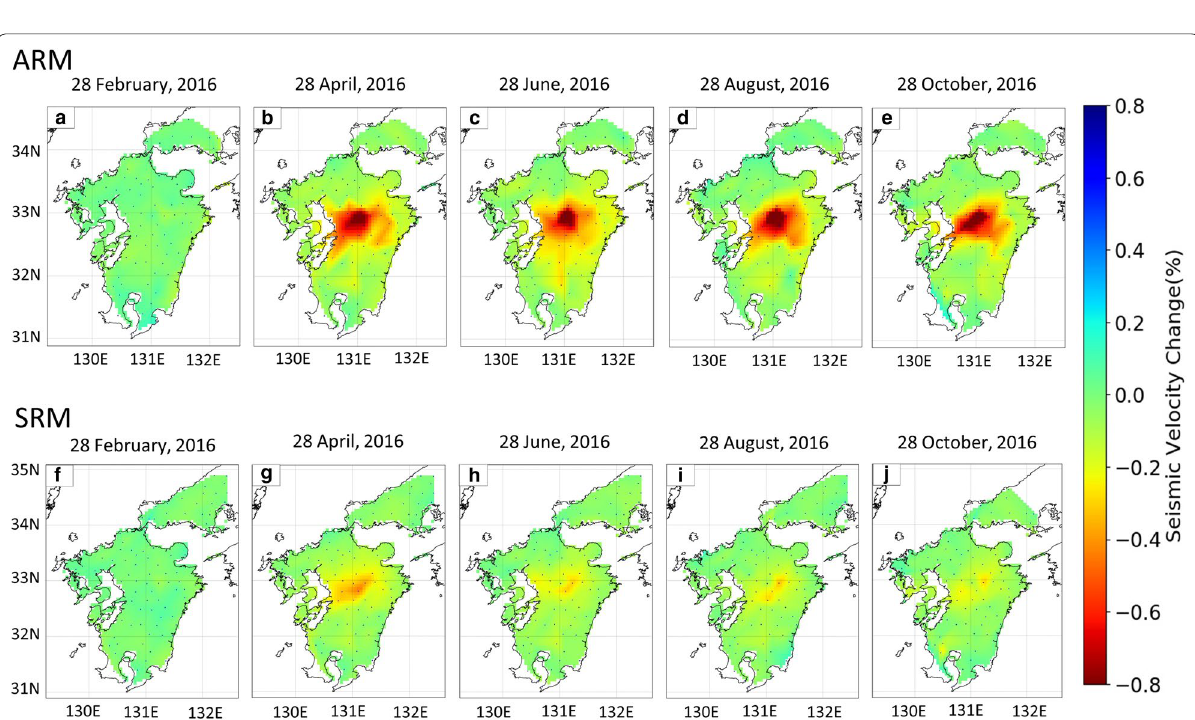
Fig. 7 Spatio-temporal velocity maps determined by using a – e the ARM and f – j the SRM. The ARM and SRM have different temporal resolutions because the current trace was made with stacking periods of 17 and 11 days, respectively. Both methods identified spatio-temporal velocity changes caused by the Kumamoto earthquake. But, the velocity changes derived from both methods are largely